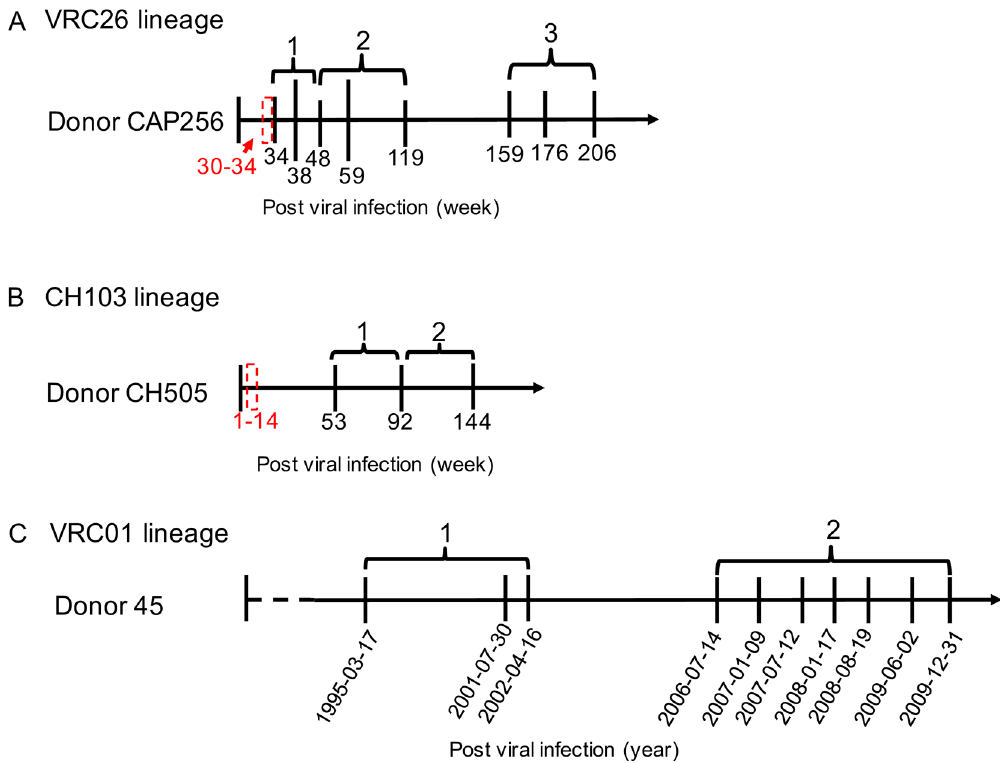
Fig 1. Study periods of the VRC26, CH103, and VRC01 lineages. To study the dynamics of evolutionary rate, selection pressure and mutability over time, we separated the time points of a lineage into two or three stages. (A) Time points of the CAP256-VRC26 lineage for which curated antibody variable region sequences were available. The eight time points were divided into three stages, which are listed above the time scale. (B) Time points of the CH103 lineage, with sequence data available at three time points, which were divided to two stages. (C). Study period of the VRC01 lineage. Since the exact date of HIV-1 infection is unavailable for this donor, the infection period before VRC01 lineage study initiation was represented with a dashed line. The approximate lineage initiation times for the VRC26 and CH103 lineages were labeled with red boxes.